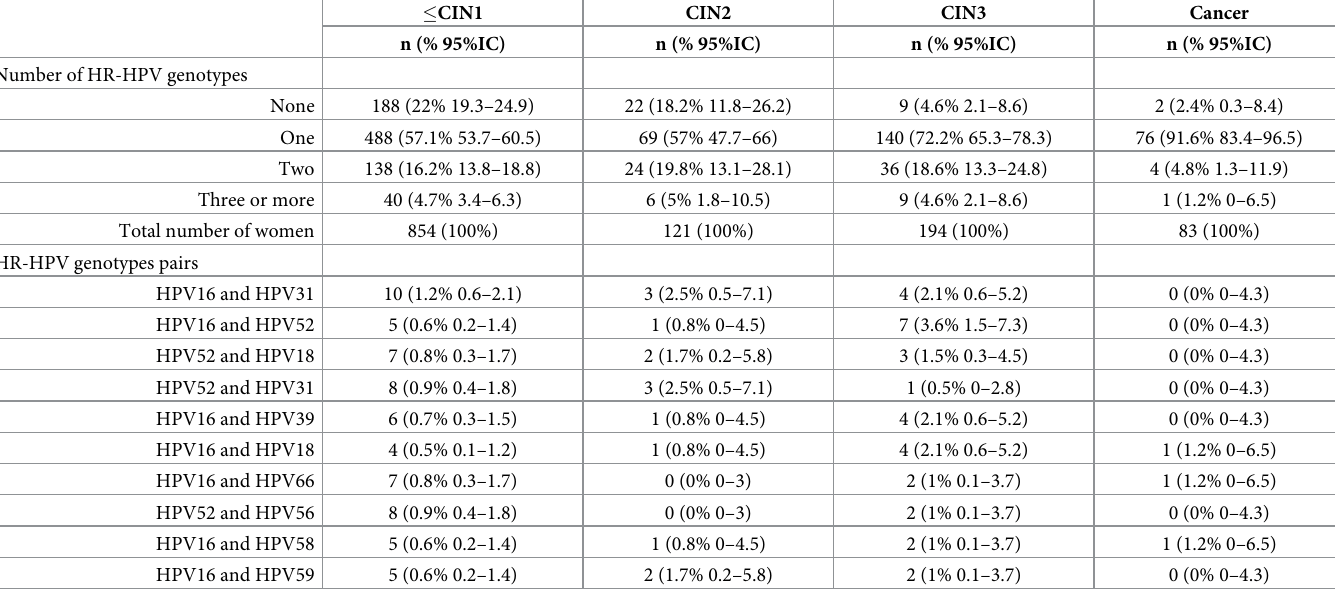
Table 4. Number of high-risk (HR)-HPV genotype infections within histological diagnoses in HPV screened positive women and most common HR-HPV co-